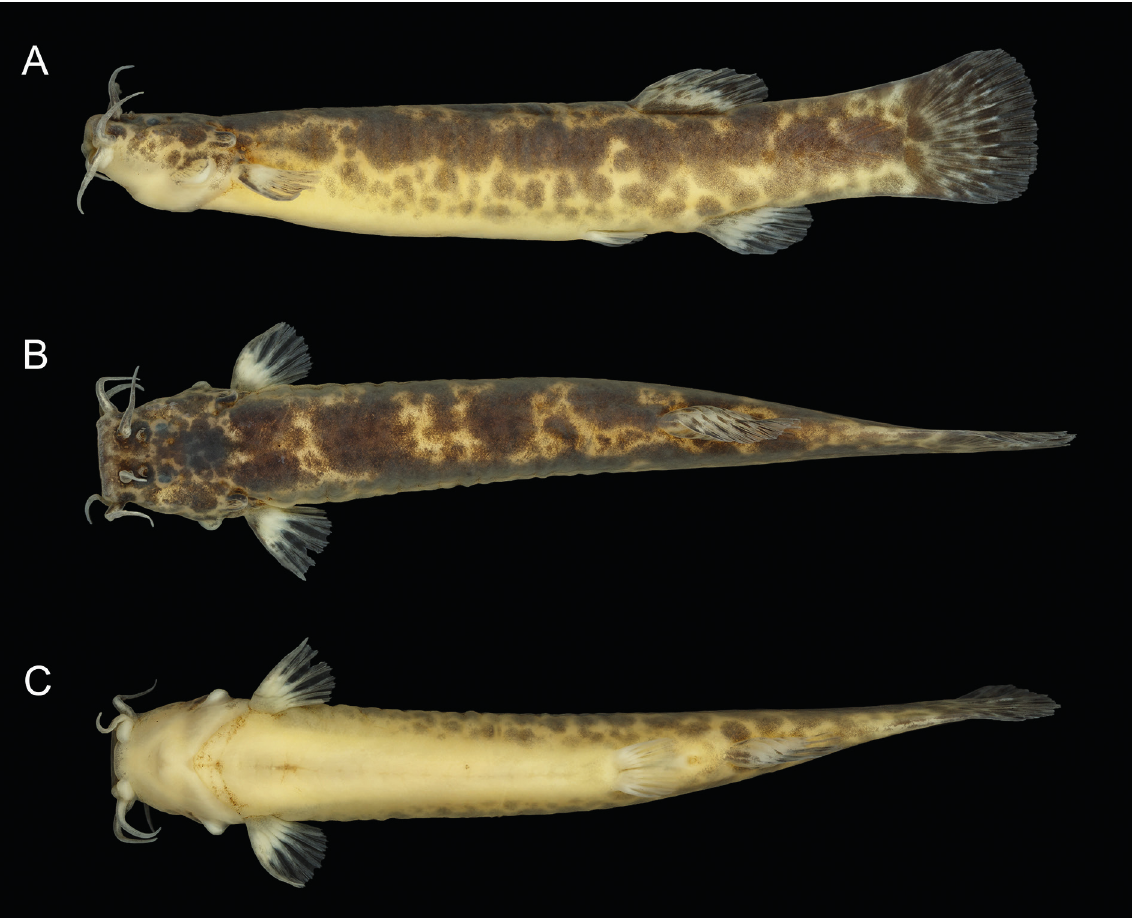
Fig. 5. Cambeva betabelardense sp. nov., holotype (UFRJ 6995), 42.7 mm SL. A . Left lateral view. B . Dorsal view. C . Ventral